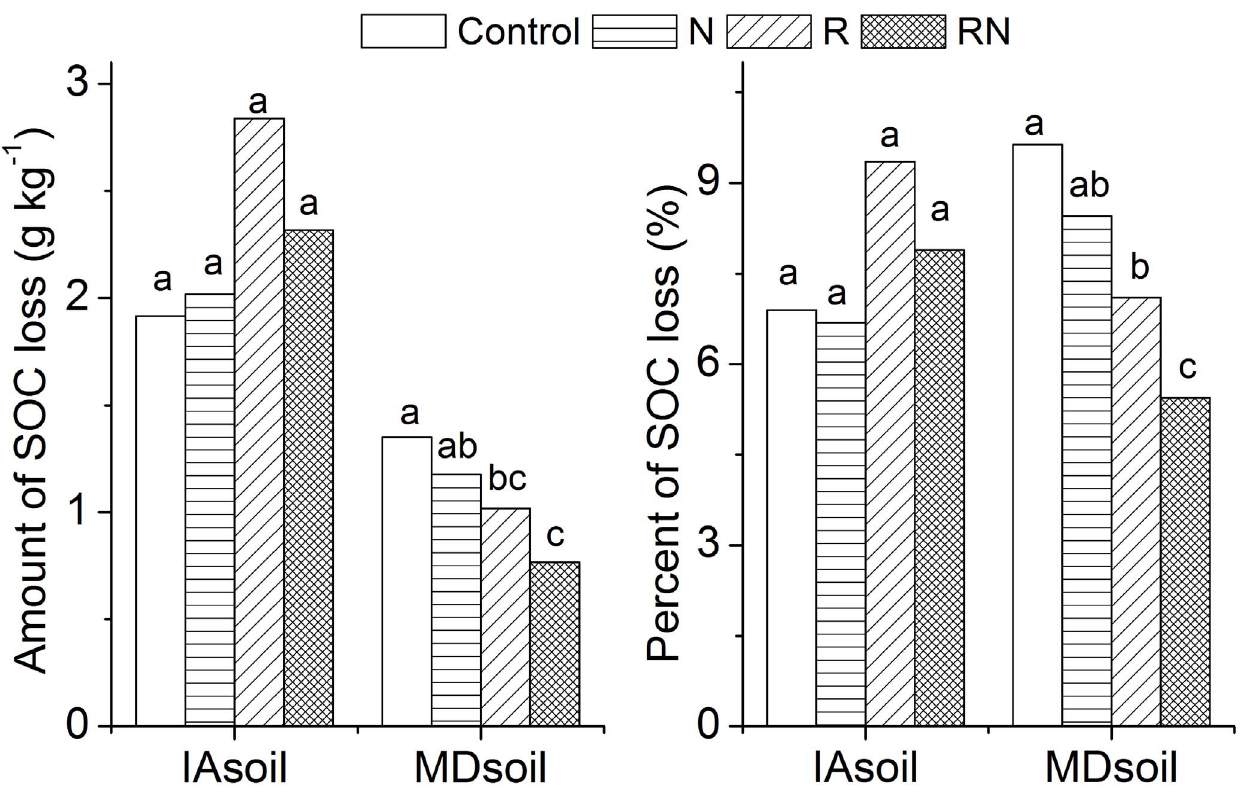
Figure 2. Amount and percentage of SOC loss comparing with initial SOC content. Control: treatments with no residue or N fertilizer added. N: treatments with N fertilization. R: treatments with residue application. RN: treatments applied with both residue and N fertilizer. Different letters above the bar suggest significant differences at p , 0.05, comparisons were performed in different treatments within each site (IAsoil, MDsoil).